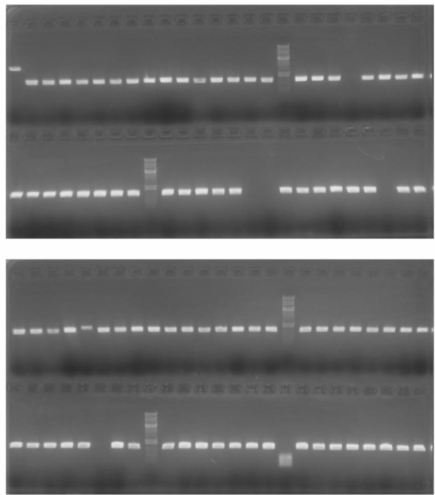
Figure 4. Analysis of spun-down PCR samples by DNA agarose gel electrophoresis. The colony-PCR samples for positive clone screening were stained with EZ-Vision One DNA 6 × loading bu ff er, separated by 1.2% agarose gel electrophoresis [20], and visualized by a combination of a black light and a longpass emission-filter (SC-46, Fujifilm, Tokyo, Japan) [19].